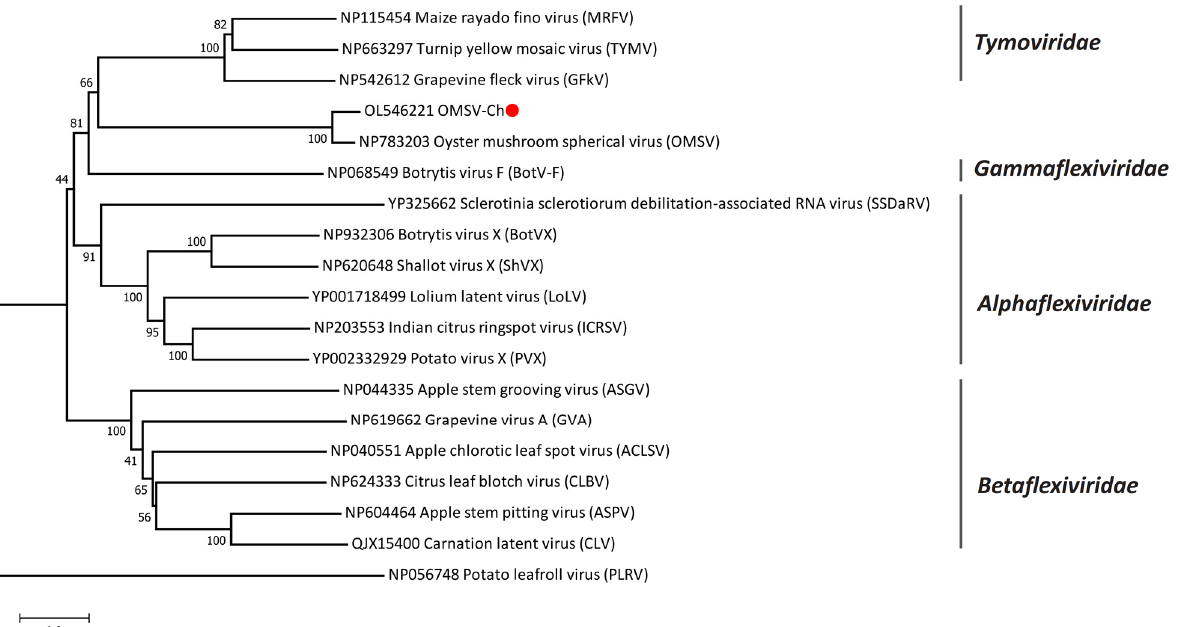
Figure 3. Phylogenetic analysis of the OMSV-Ch replication protein ( a ) and coat protein ( b ) with corresponding proteins of tymoviruses, marafiviruses, and maculaviruses. The OMSV-Ch sequence from the present study is marked with a red dot. Potato virus X (PVX) was used as an outgroup.